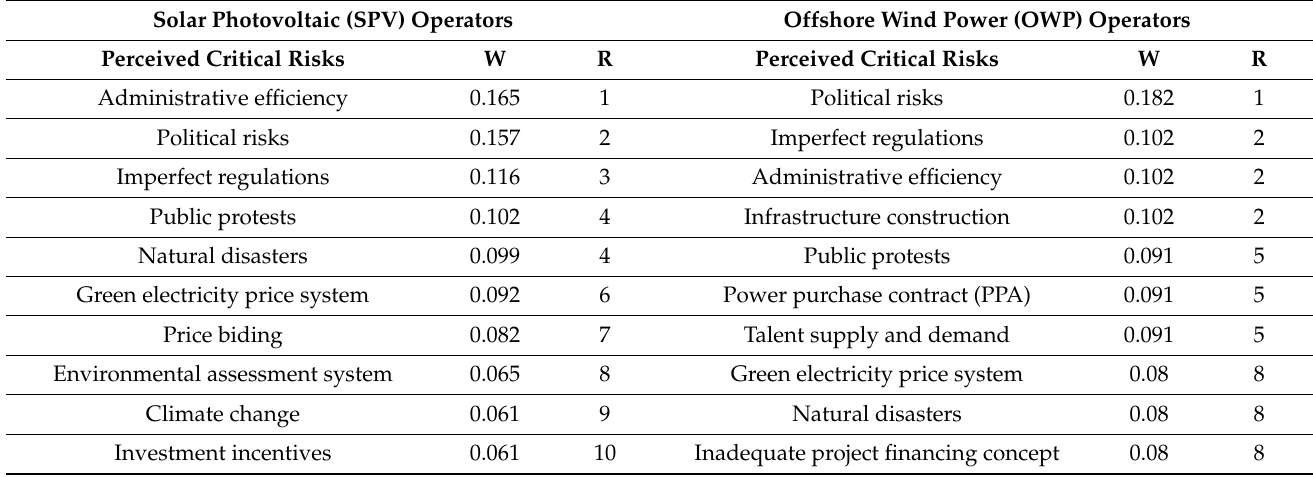
Table 6. The 10 most commonly recognized key risks for SPV and OWP businesses from